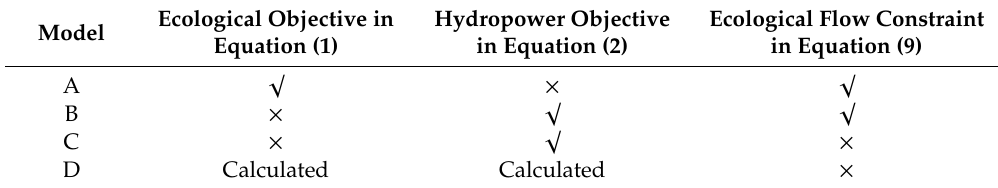
Table 1. Comparison for di ff erent